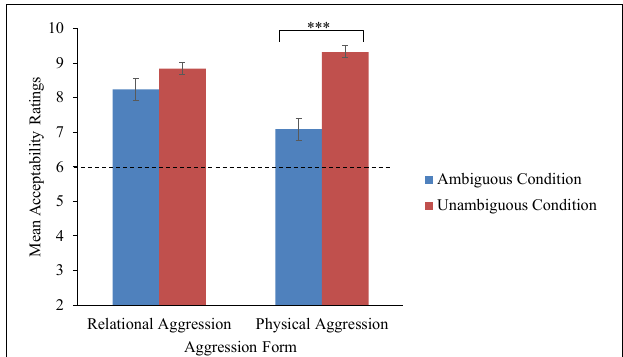
FIGURE 3 | Mean acceptability ratings by aggression form and ambiguity condition across age groups. Error bars represent SEs. Note that acceptability ratings were coded as follows: 1, not at all; 2, a little; 3, sort of; 4, a lot; and 5, a whole lot. Ratings were summed across transgressor gender, resulting in a range of 2–10. *** Indicates a significant difference ( p < 0.001) between the ambiguous and unambiguous